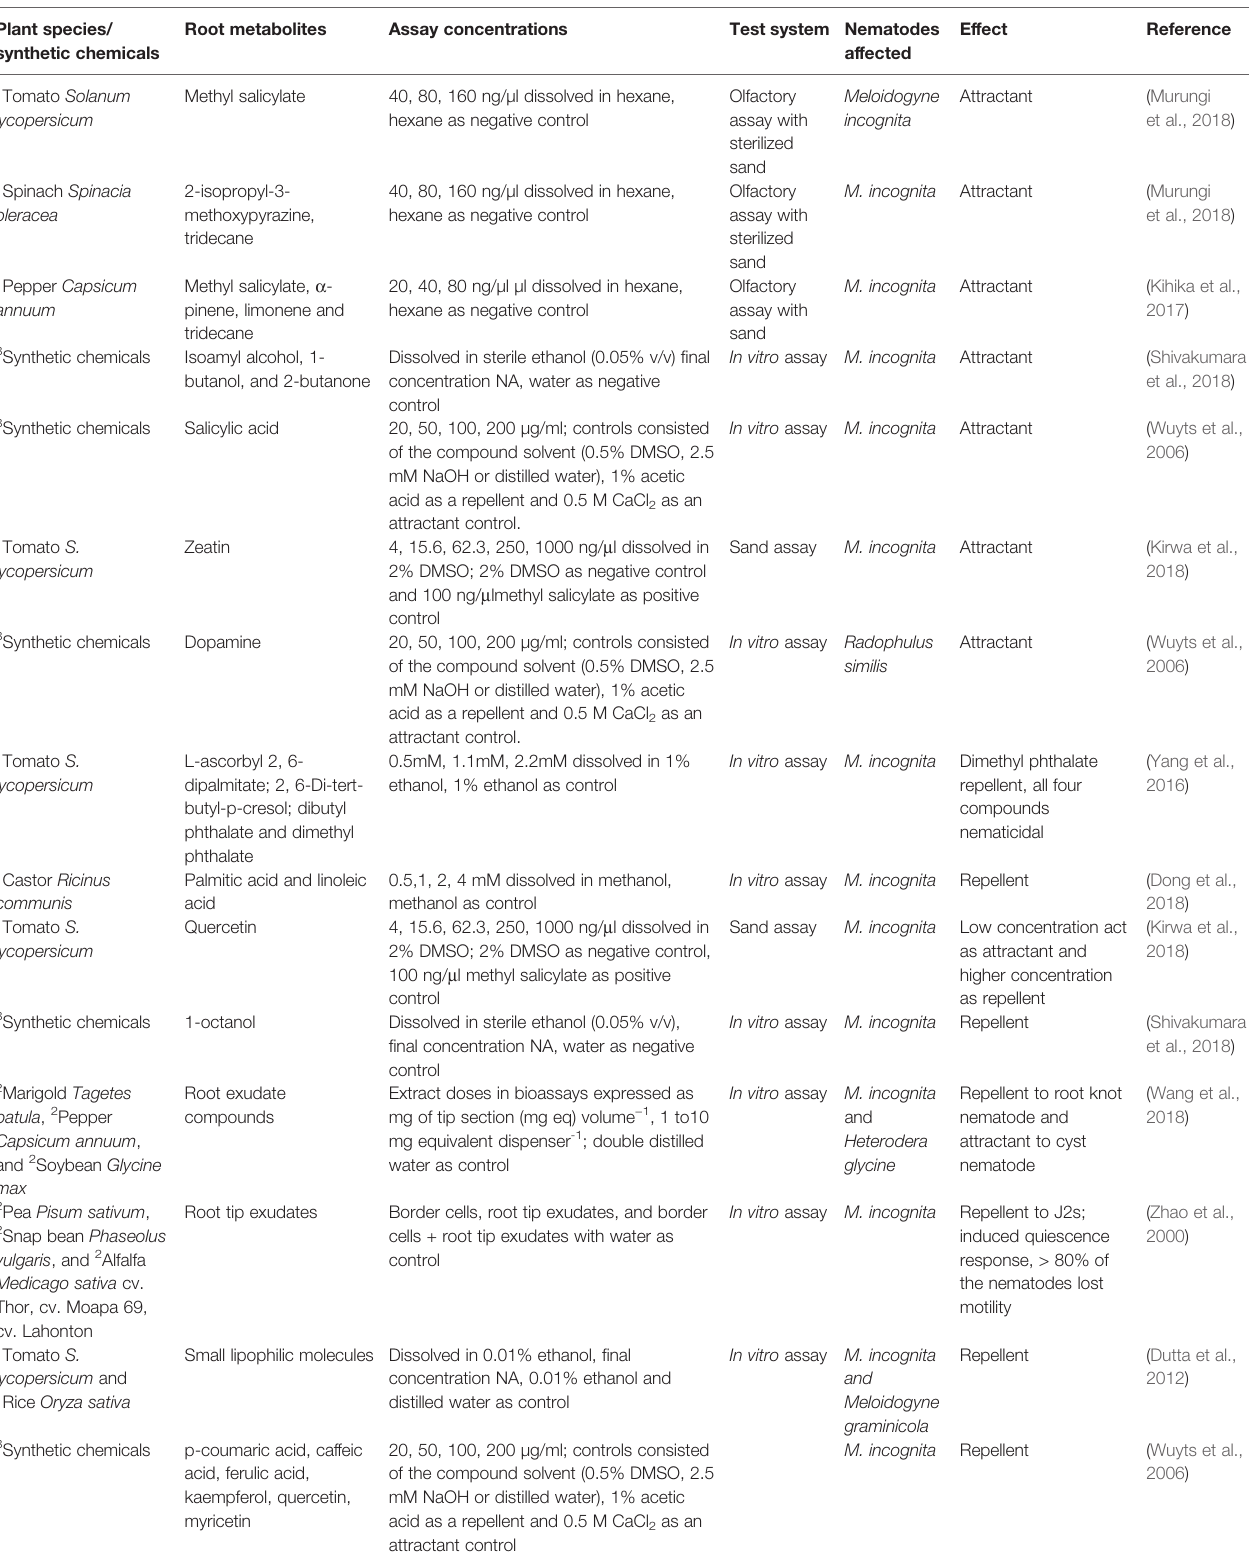
TABLE 1 | Root metabolites affecting nematode